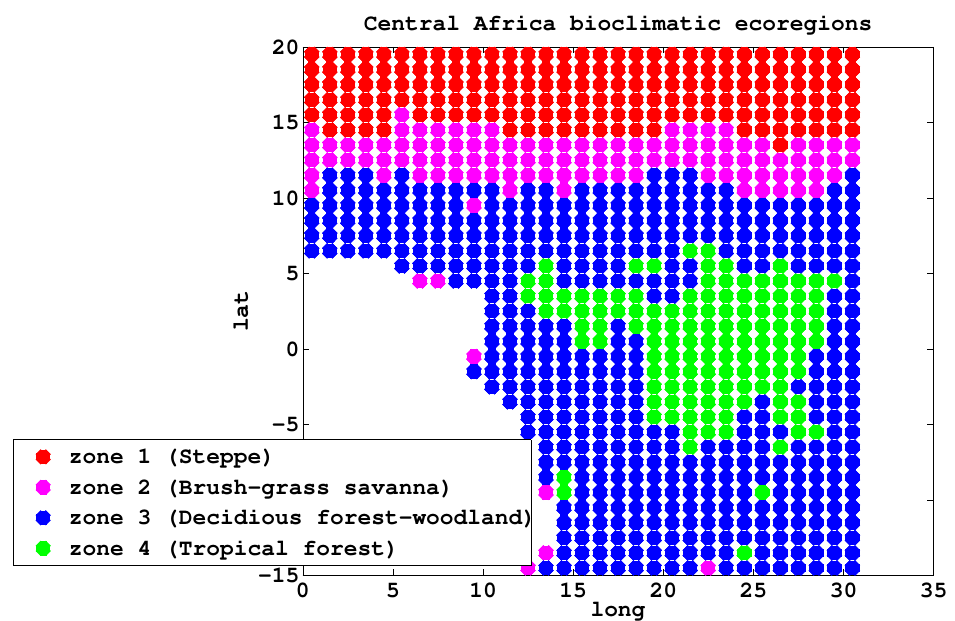
Supervised classification, with 1 ◦ × 1 ◦ spatial resolution, of four bioclimatic ecoregions in the area of Central